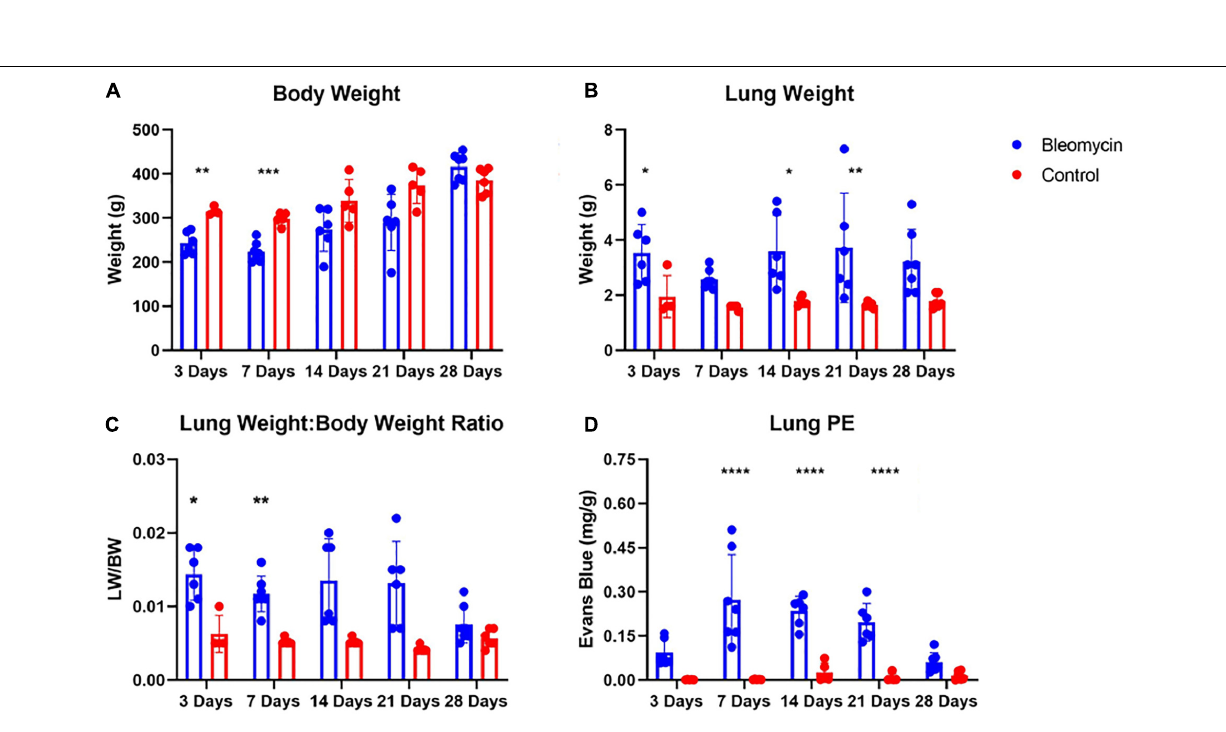
FIGURE 2 | Body weight (A) and lung weight (B) for Bleo and sham rats (A) . Lung edema was indirectly estimated by obtaining lung weight and body weight ratio (C) . Bleo induces plasma extravasation within the lung at 7-, 14-, and 21-days (D) . Mean ± SD. n = 5–7 per group. Comparing bleomycin with control group * P < 0.05, ** P < 0.005, *** P < 0.0005, **** P <